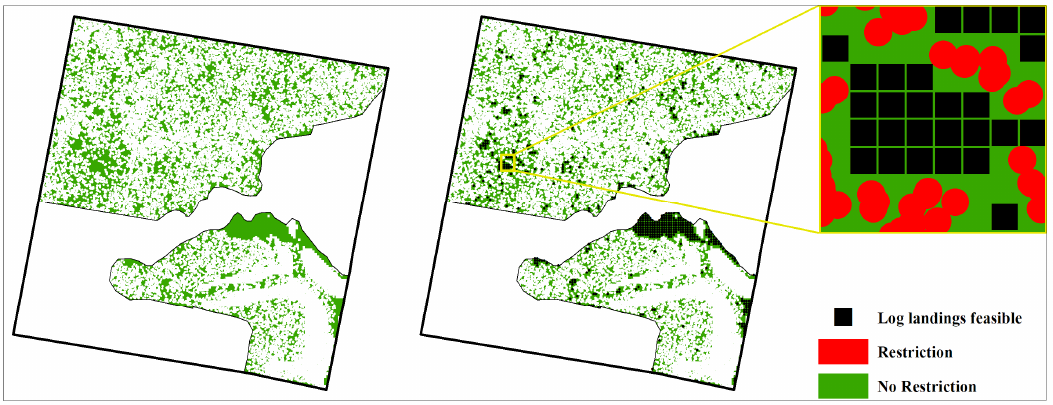
Figure 5. Location of feasible yards to store harvested log.